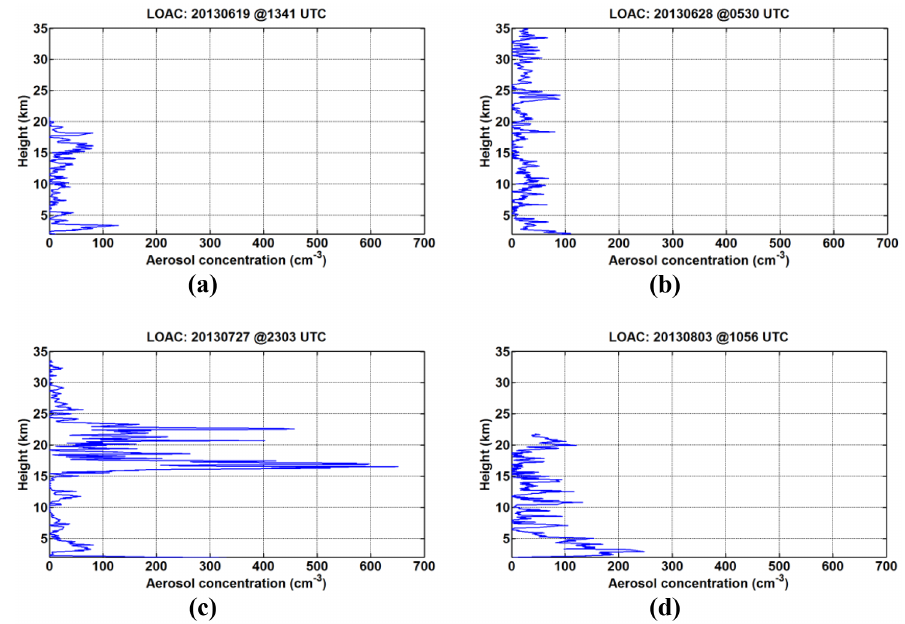
Figure 1. 50m interpolated vertical profiles of aerosol concentration (cm − 3 ) with diameters 0.2–50µm above Minorca Island (39.99 ◦ N, 4.25 ◦ E) (a–b) on 19 June at 13:41UTC and 28 June at 05:30UTC respectively, and above Ile du Levant (43.02 ◦ N, 6.46 ◦ E) (c–d) on 27 July at 23:03UTC and 3 August at 10:56UTC during the 2013 ChArMEx